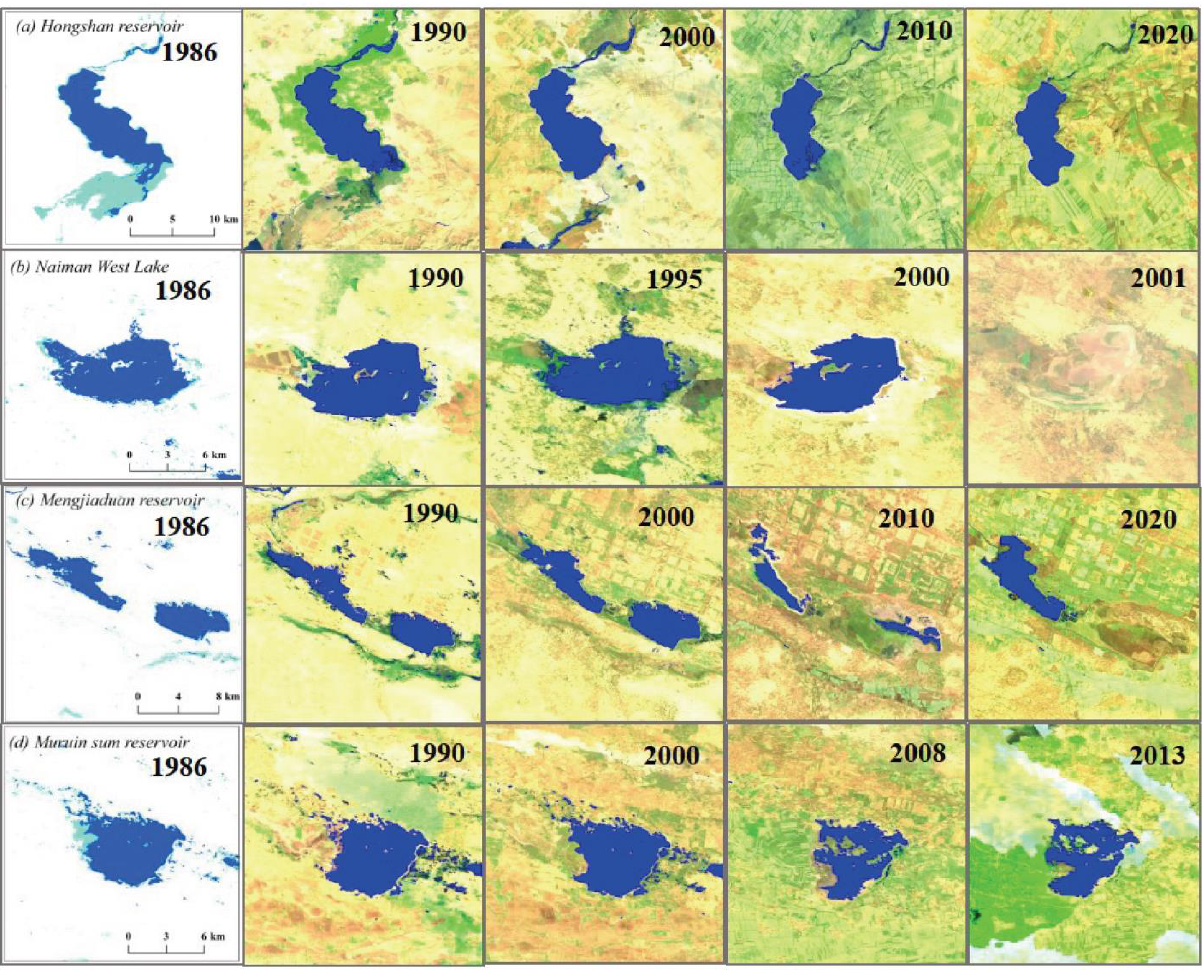
Figure 7. Spatiotemporal variation of water extent on several larger reservoirs and a lakes during the period 1985–2020. ( a ) Hongshan reservoir, ( b ) Naiman west lake, ( c ) Mengjiaduan reservoir, and ( d ) Muruin Sum reservoir; they are displayed over Landsat 5 TM images with bands 7, 4, and 2 and Landsat 8 OLI images with bands 7, 5, and 3.